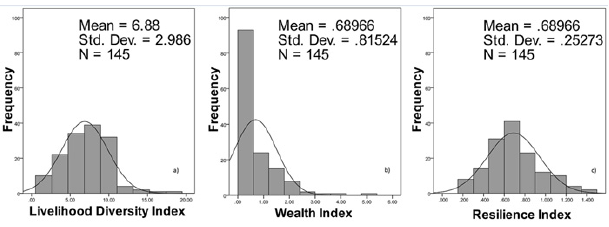
Fig. 6 . Distribution of the different indices of resilience across Habu households, showing a) Livelihood Diversity, b) Wealth Index, and c) Resilience